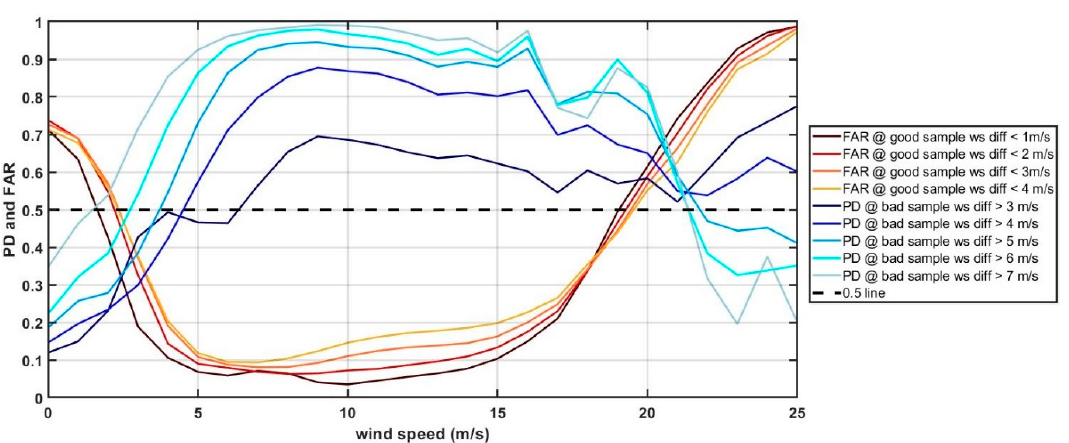
Figure 5. Family of PD and FAR curves for different definitions of good and outlier samples. The dark-light blue curves represent PD and the orange-red curves represent FAR.